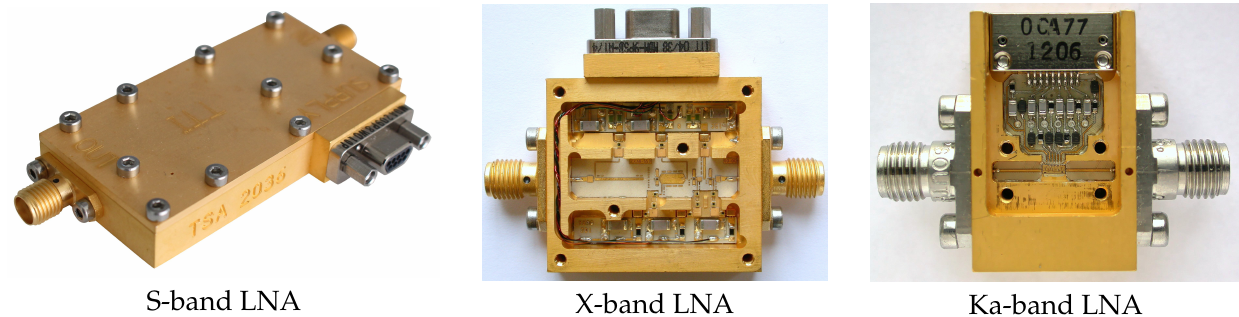
Figure 9. Cryogenic low noise amplifiers for the tri-band feed in S, X, and Ka bands. All amplifiers units were characterized at cryogenic temperature in the closed-cycle helium dewars of Yebes laboratories. Noise performance was measured using the cold attenuator method as described in Reference [11]. An absolute accuracy ( 2 σ ) at